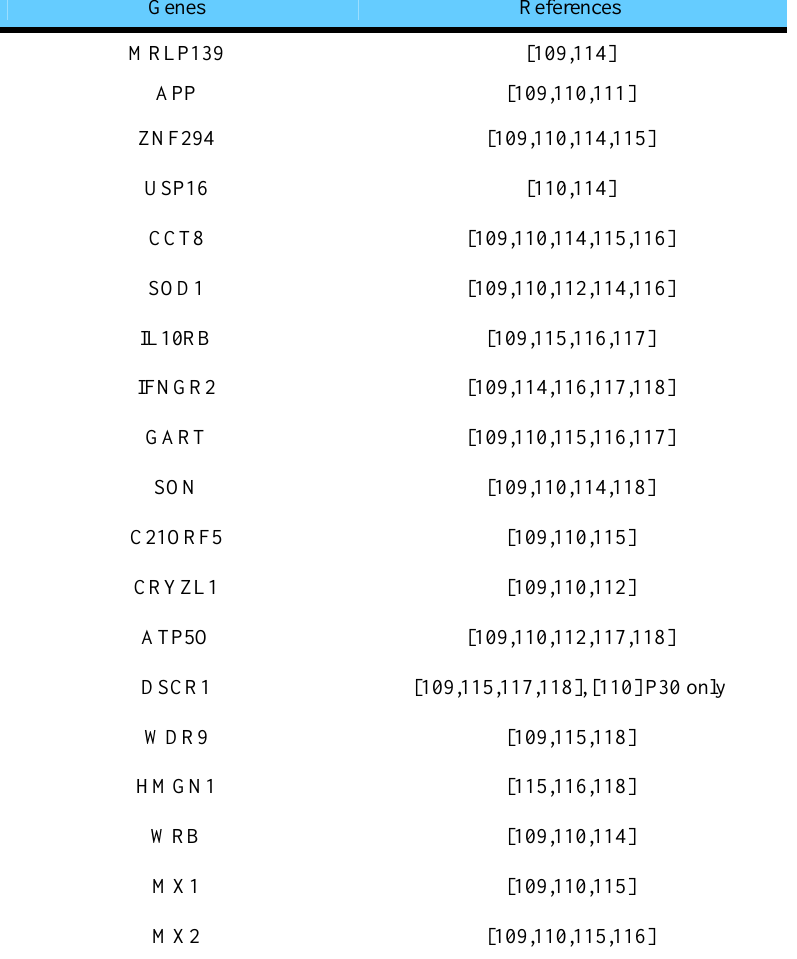
HSA21 and Mouse Orthologs Dosage-Sensitive Genes